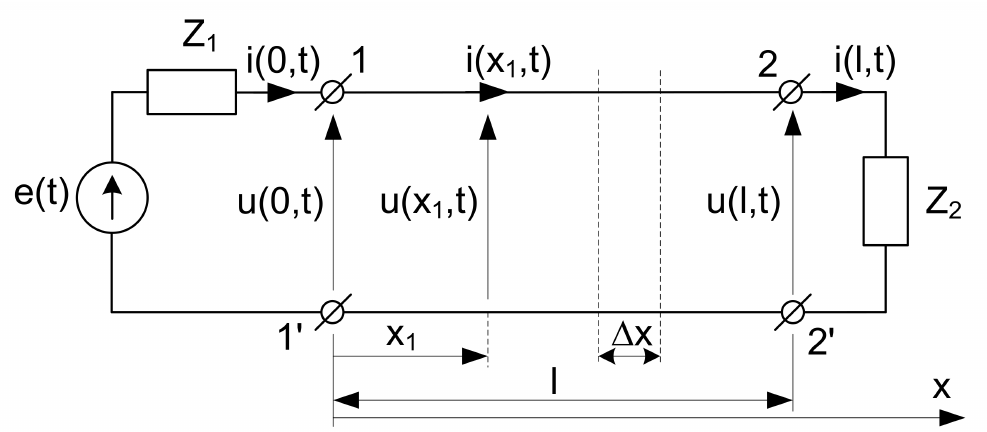
Figure 1. Model of a two-wire transmission